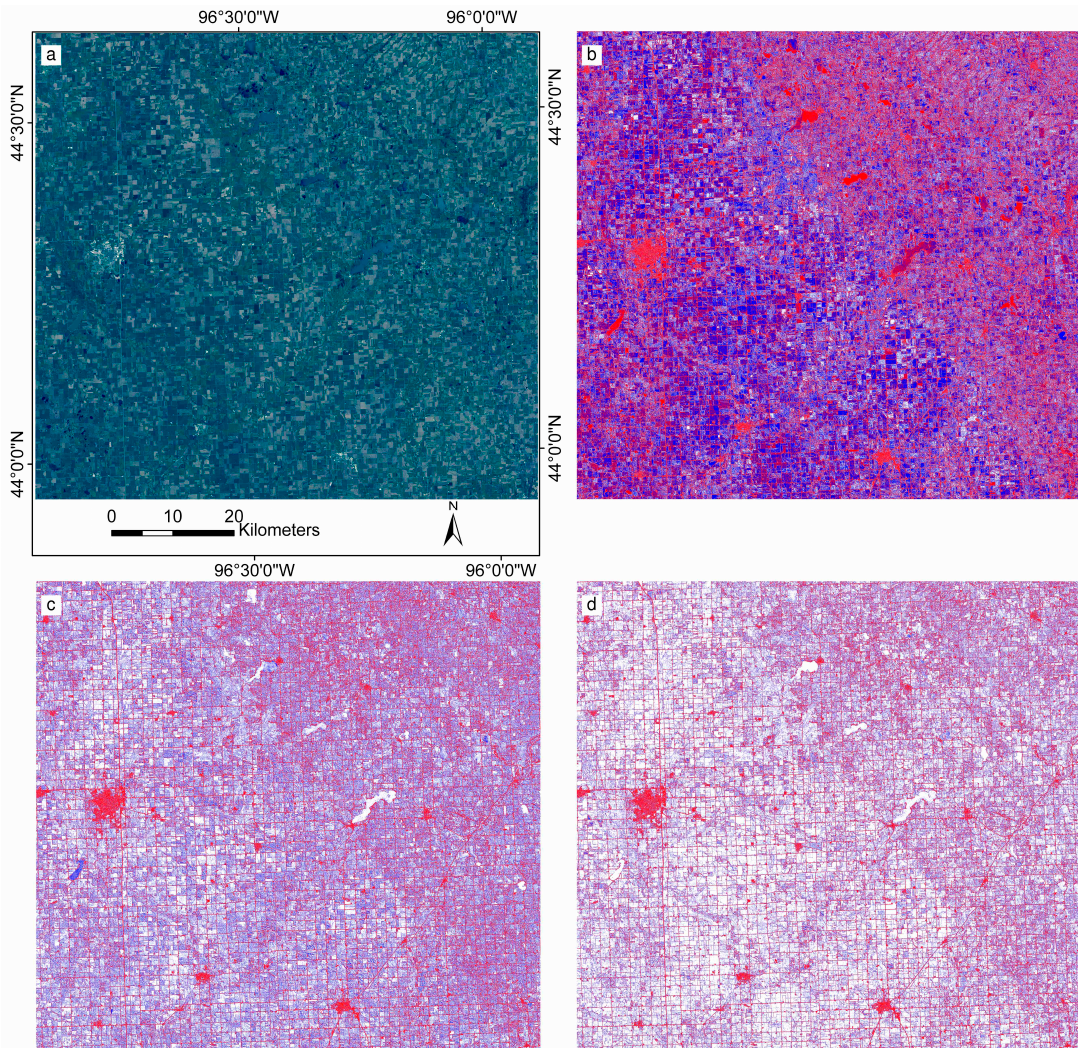
Figure 3. South Dakota 2734 × 2532 30 m Landsat 8 top of atmosphere (TOA) red, green, blue TOA reflectance ( a ). Absolute reflectance differences between the 15m panchromatic band and the 15 m resampled intensity images generated using: the equal spectral weights ( w red = w green = w blue = 1 { 3 ) ( b ); the spectral response function based (SRFB) spectral weights ( w red = 0.4030, w green = 0.5177, w blue = 0.0802) ( c ); and the image specific spectral weights ( w red = 0.4516, w green = 0.5981, w blue = − 0.0588) ( d ). Absolute reflectance differences colored as: 0 ≤ white < 0.0035, 0.0035 ≤ blue < 0.0070, and red ≥ 0.0070. The 30 m true color and the 30 m intensity images were cubic convolution resampled to the 15 m panchromatic band grid.